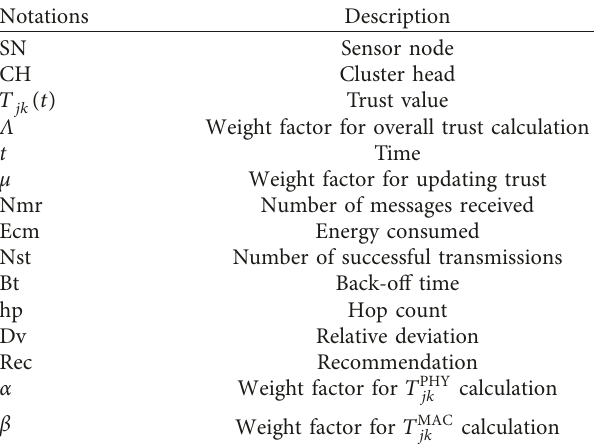
Table 1: Notation and